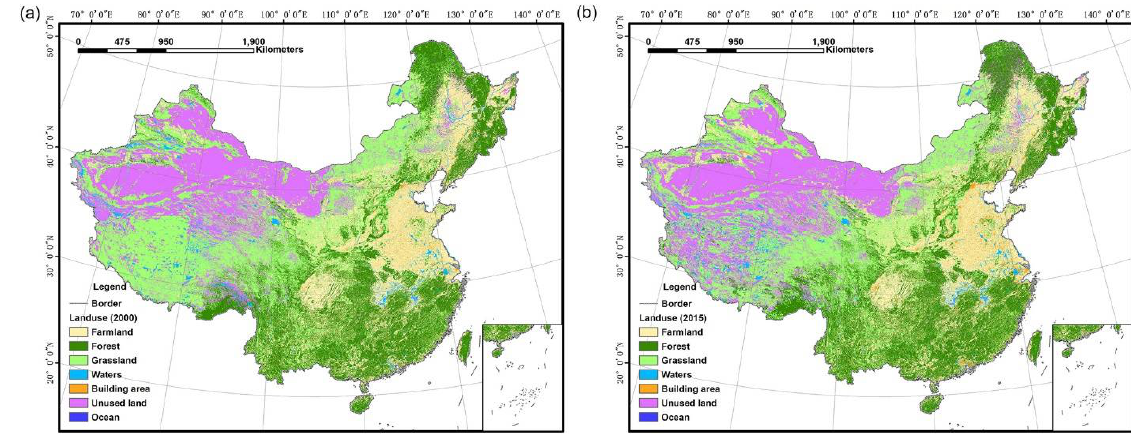
Figure 2. Land use in China in ( a ) 2000 and ( b ) 2015 at a 30 m spatial resolution. Table 1. Land use in 2000 and 2015.